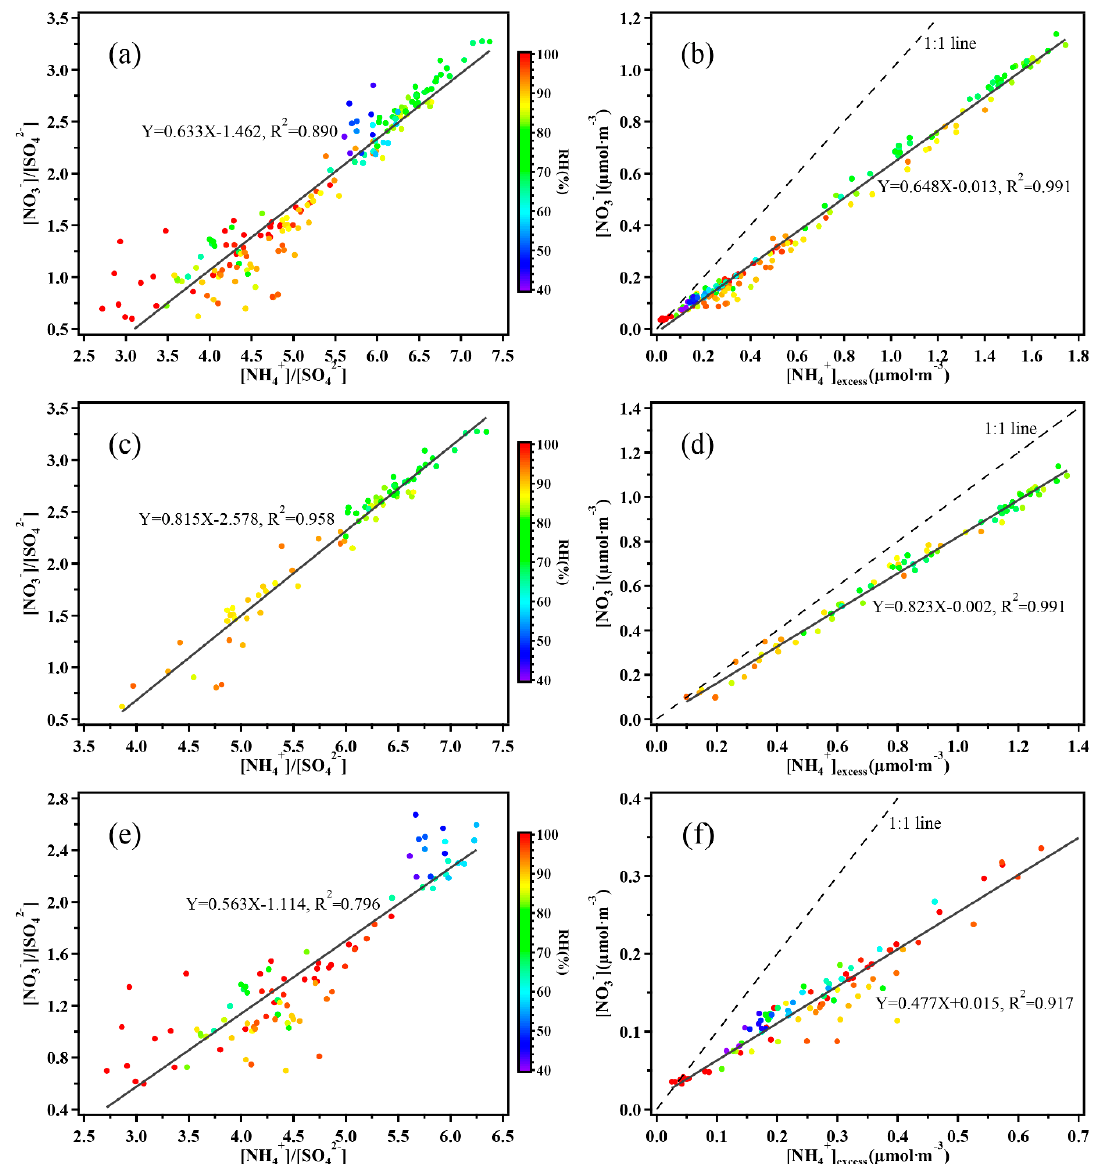
Figure 9. Linear regressions of [NH 4+ ]/[SO 42 − ] to [NO 3 − ]/[SO 42 − ] during ( a ) whole studied periods, ( c ) haze periods and ( e )non-haze periods and the linear relationship of [NO 3 − ] to [NH 4+ ] excess during ( b ) the whole studied periods, ( d ) haze periods and ( f ) non-haze periods.